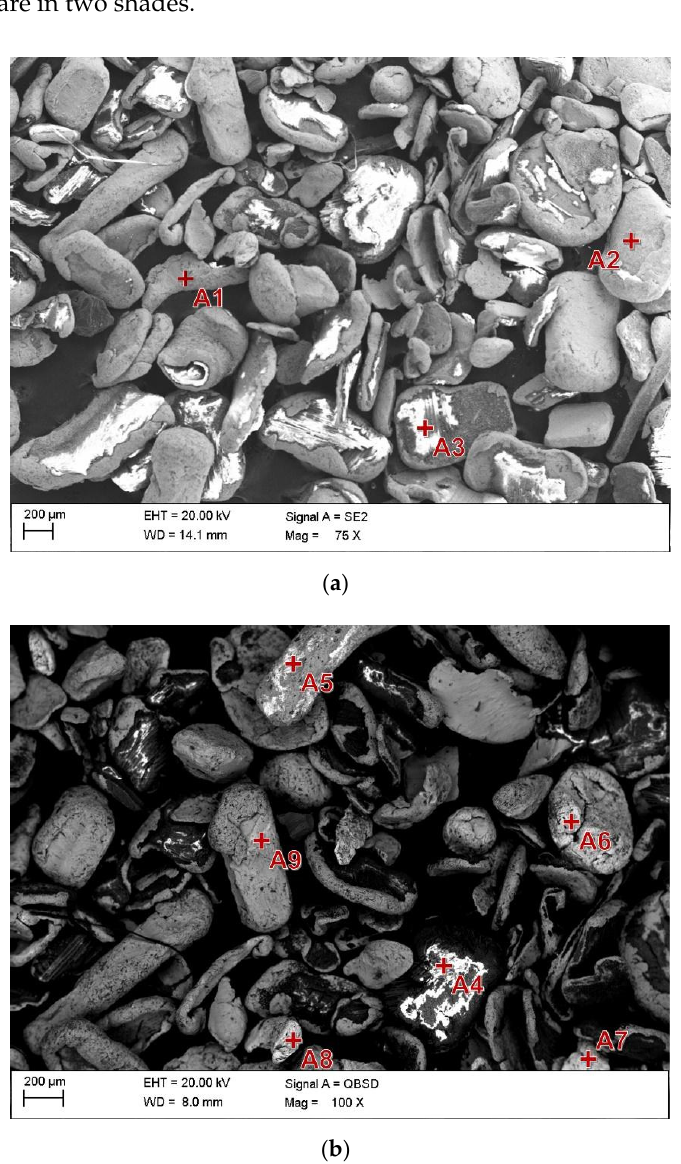
Figure 5. Concentrate from the electrostatic separation (SEM, QBSD mode (Table 4)) with marked EDS analysis points: ( a ) A1–A3 and ( b ) A5–A9.